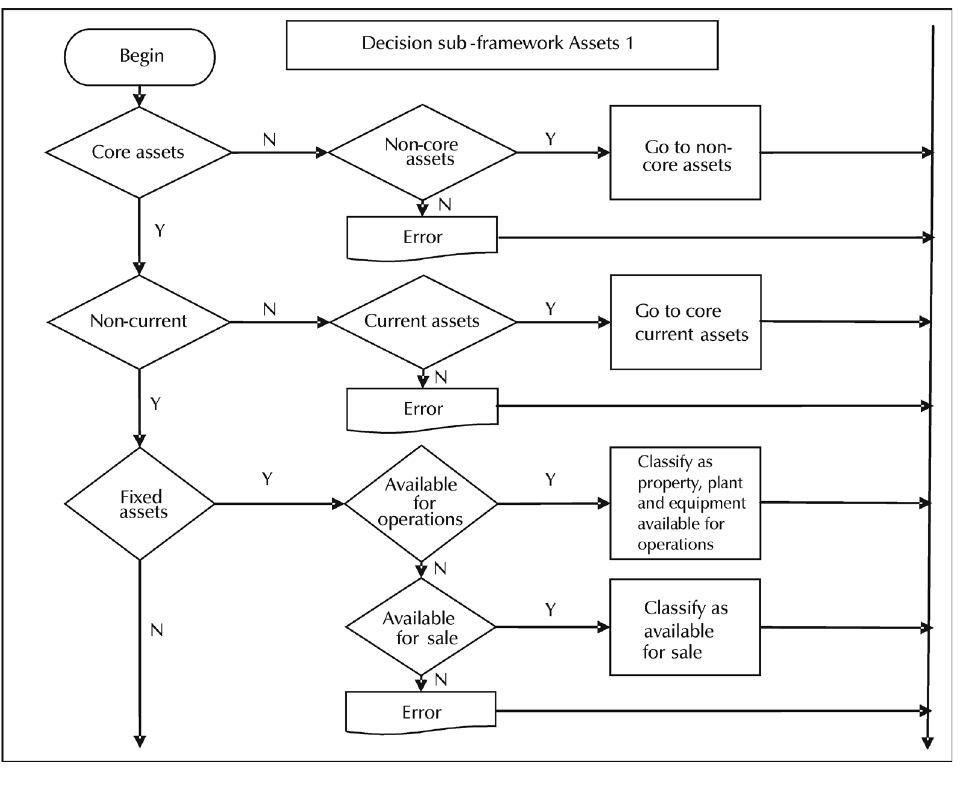
Extract from the developed decision sub-framework for assets